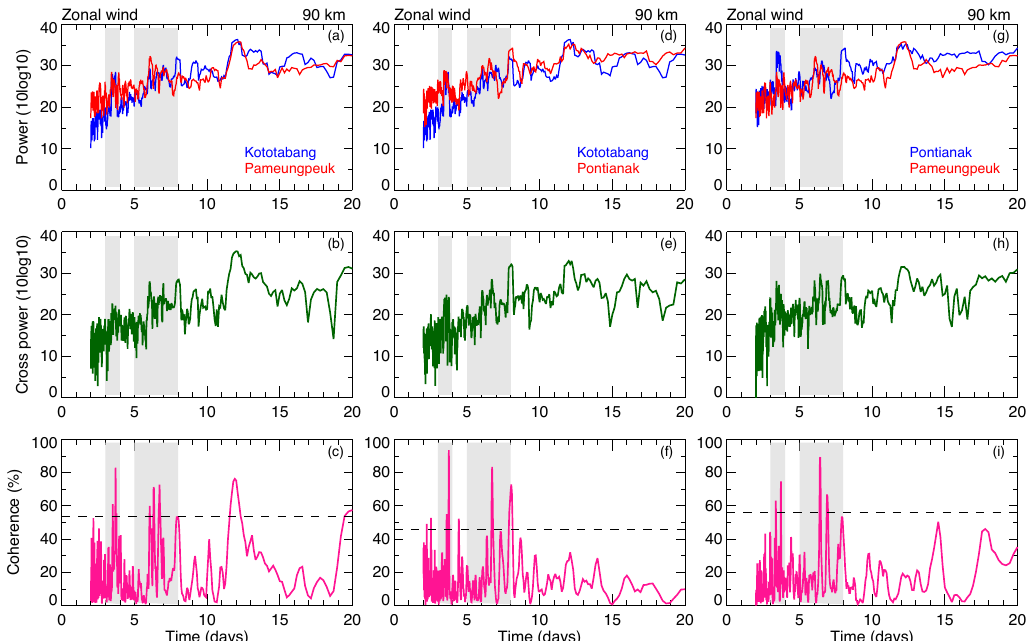
Figure 2. The zonal wind power spectral density of two radars (a, d, g) , cross power spectral density (b, e, h) , and coherence (c, f, i) during 1 April to 31 May 2010.